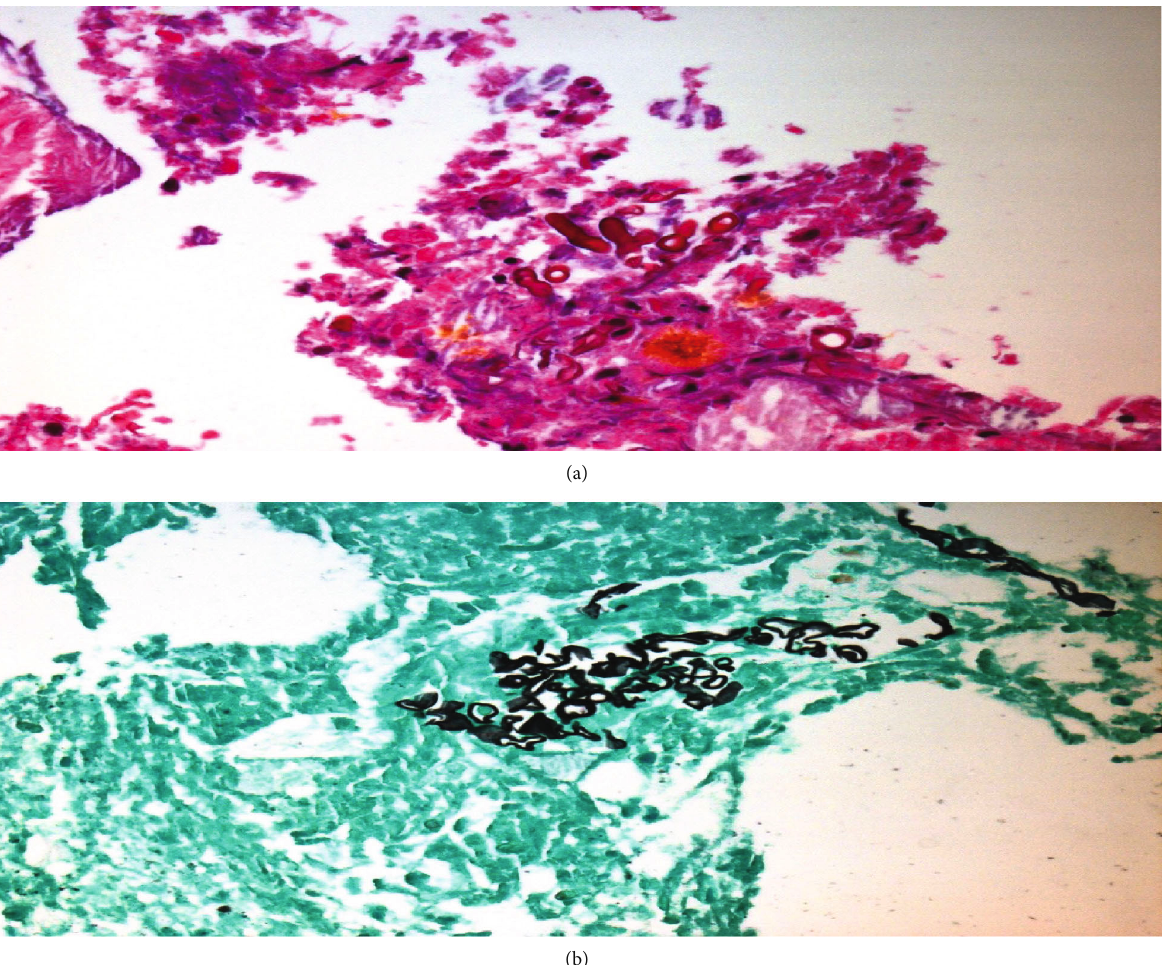
Figure 2: (a) Hematoxylin-eosin (H&E) stain. (b) Grocott Methenamine Silver (GMS) stain. (a, b) Examination of the left temporal lesions revealed an abscess due to a fungal infection (branching nonseptate hyphae). The morphology of these hyphae is suggestive of Mucor